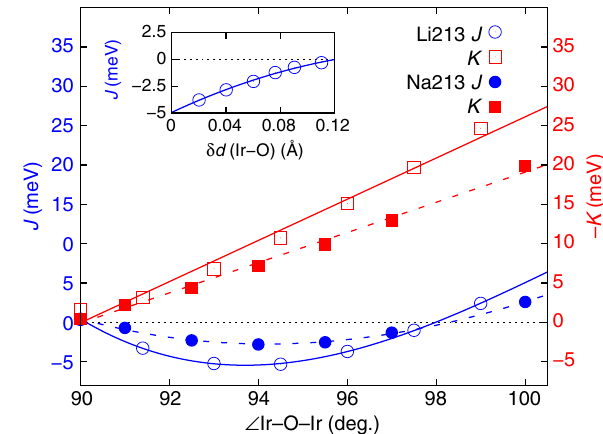
Figure 2 | Variation of the Heisenberg and Kitaev exchange couplings with the Ir–O–Ir angle in idealized honeycomb structural models. Results of spin-orbit MRCI calculations are shown, for NN Ir–Ir links in both Li213 (continuous lines) and Na213 (dashed). For each system, the NN Ir–Ir distances are set to the average value in the experimental crystal structure 15,26 and the Ir–O bond lengths are all the same. Consequently, J ¼ J 0 and K ¼ K 0 . The variation of the Ir–O–Ir angles is the result of gradual trigonal compression. Note that J j j , K j j t 1meVat 90 (cid:2) . Inset: dependence of the NN J in Li213 when the bridging O’s are gradually shifted in opposite senses parallel to the Ir–Ir